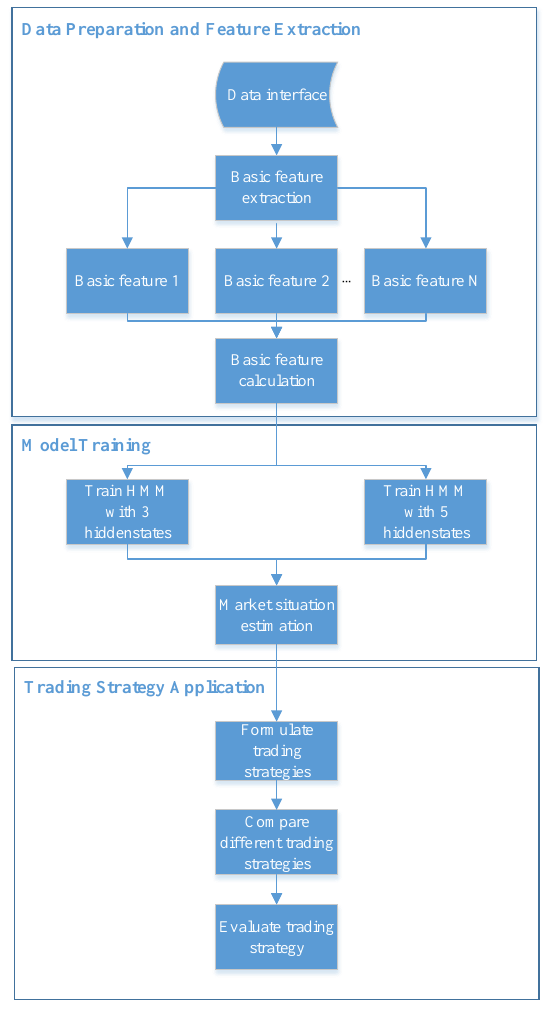
Figure 3. Model flow